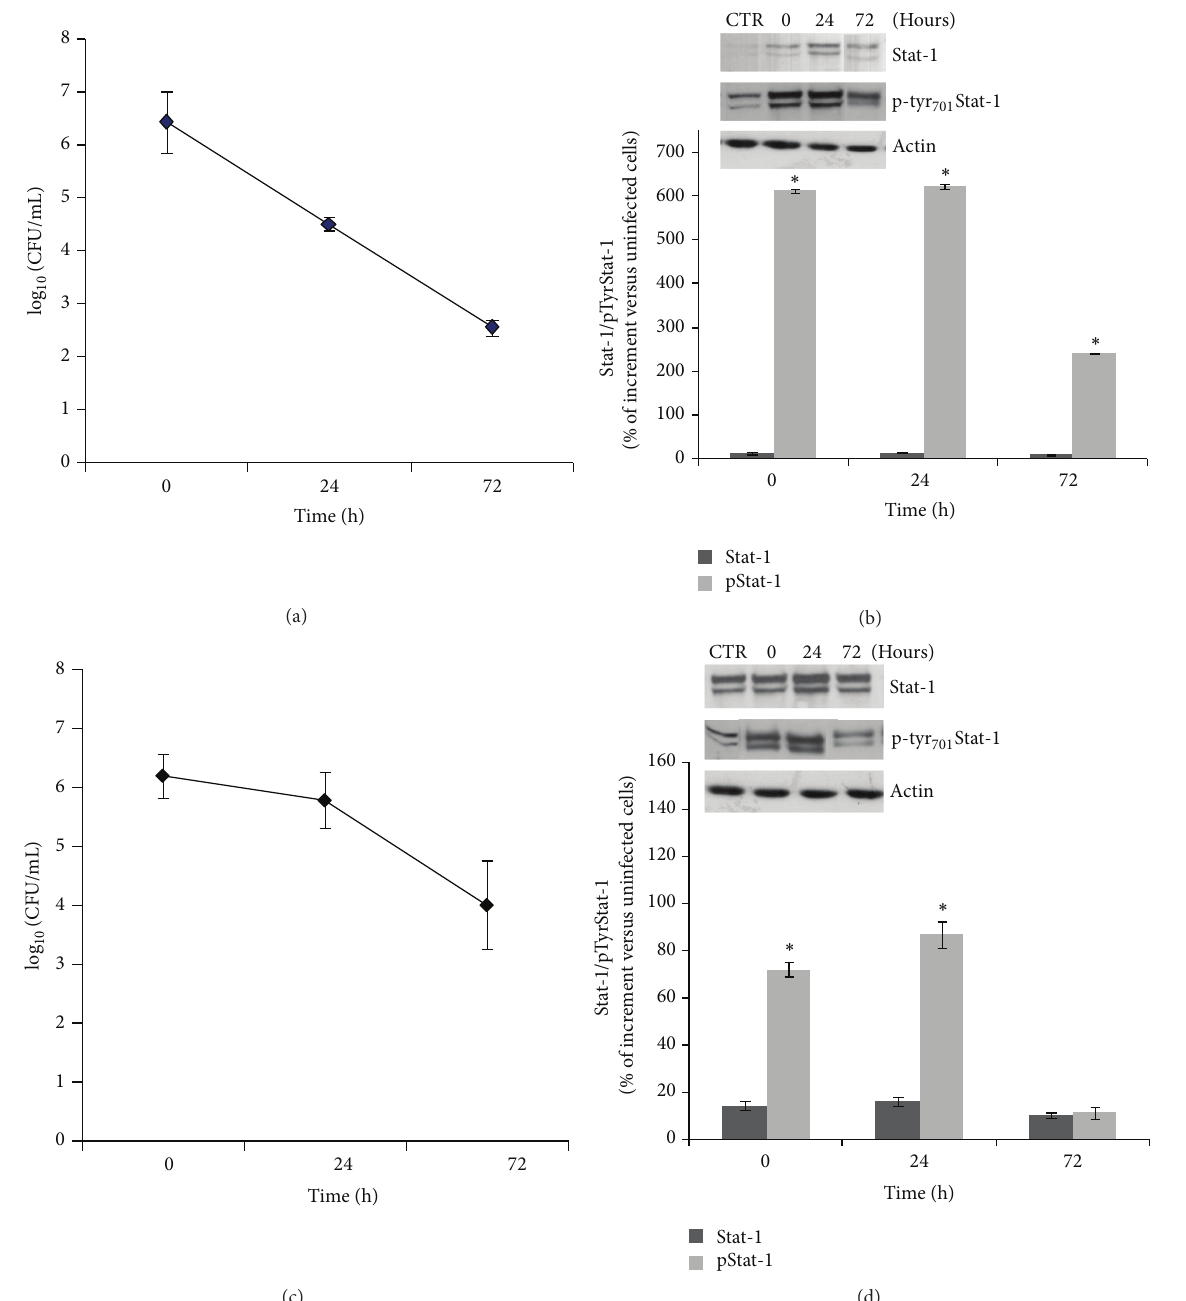
Figure 1: p-tyr 701 Stat-1 expression in human macrophages in response to Gram-positive bacterial infections. Ten-day-old macrophages were infected with Staphylococcus aureus (a, b) or Listeria monocytogenes (c, d). After removing extracellular microorganisms, cells were exposed for 30min to gentamicin to kill noningested bacteria and then cultured for an additional 3 days in fresh medium containing gentamicin. At the indicated times, the intracellular viable bacteria were determined by enumeration of CFU in specific medium ((a) and (c)) and data are the mean of three independent experiments ± SEM. Stat-1 and p-tyr 701 Stat-1 expression levels were evaluated by Western blot assay at the same times ((b) and (d)). Data were normalized on untreated (control) cells as a percentage increase. ∗ p-tyr 701 Stat- 1 expression levels are significant compared to control